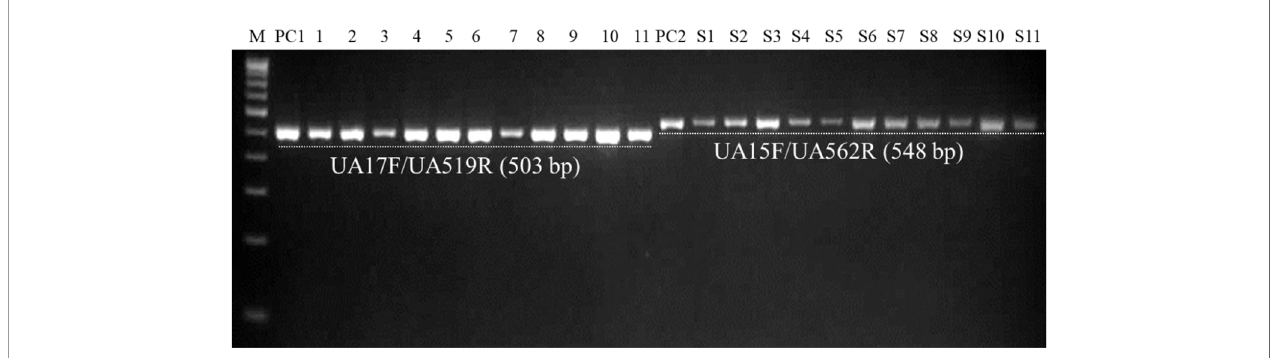
FIGURE 7 | PCR-mediated detection of U. agropyri in fi eld soil samples collected from different locations using UA-17F/UA-519R (Lanes 1 – 11) and UA-15F/UA- 562R (Lanes S1 – S11) primer sets. M, 100 bp DNA ladder; PC1, Positive control of U. agropyri FLS1 DNA for UA-17F/UA-519R primer set; PC2, Positive control of U. agropyri FLS1 DNA for UA-15F/UA-562R